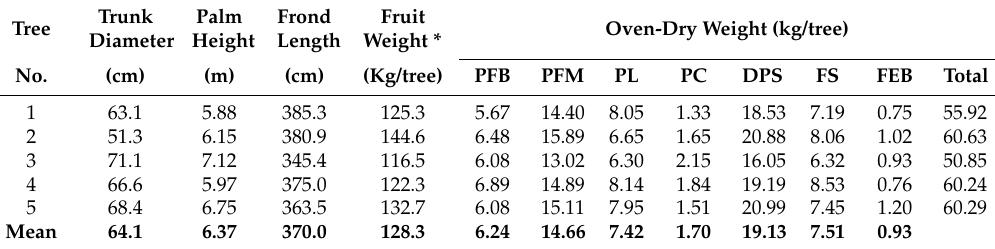
Table 1. Characterization of different part residues of the Sukkari date palm cultivar.